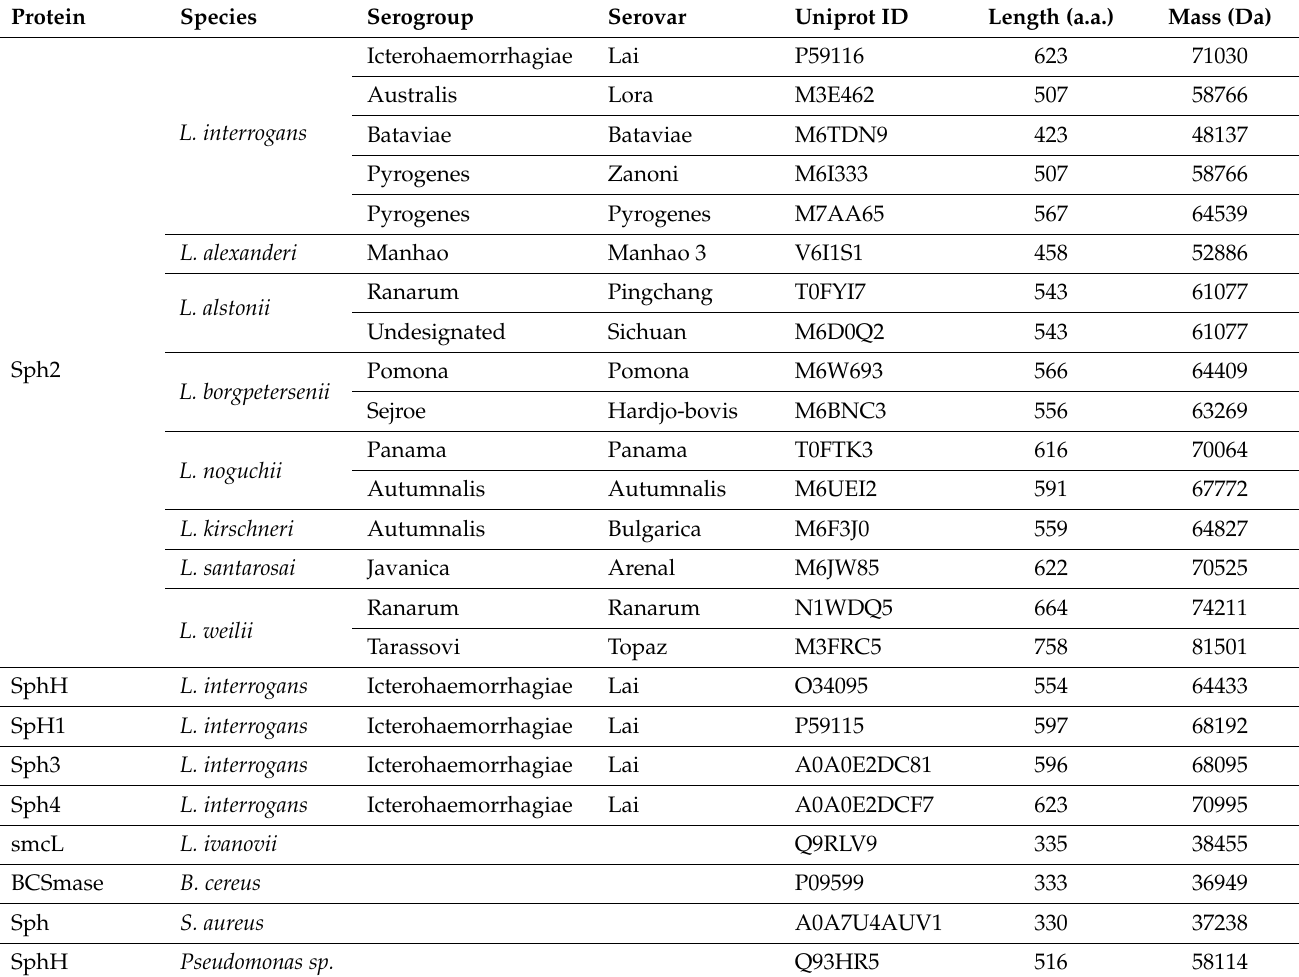
Table 1. General data of studied